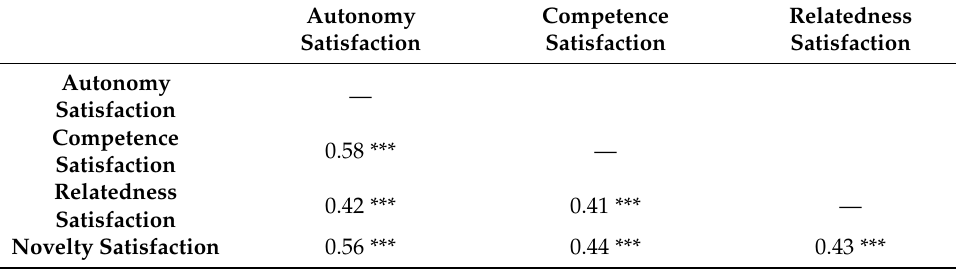
Table 4. Pearson correlation among the satisfaction of basic psychological